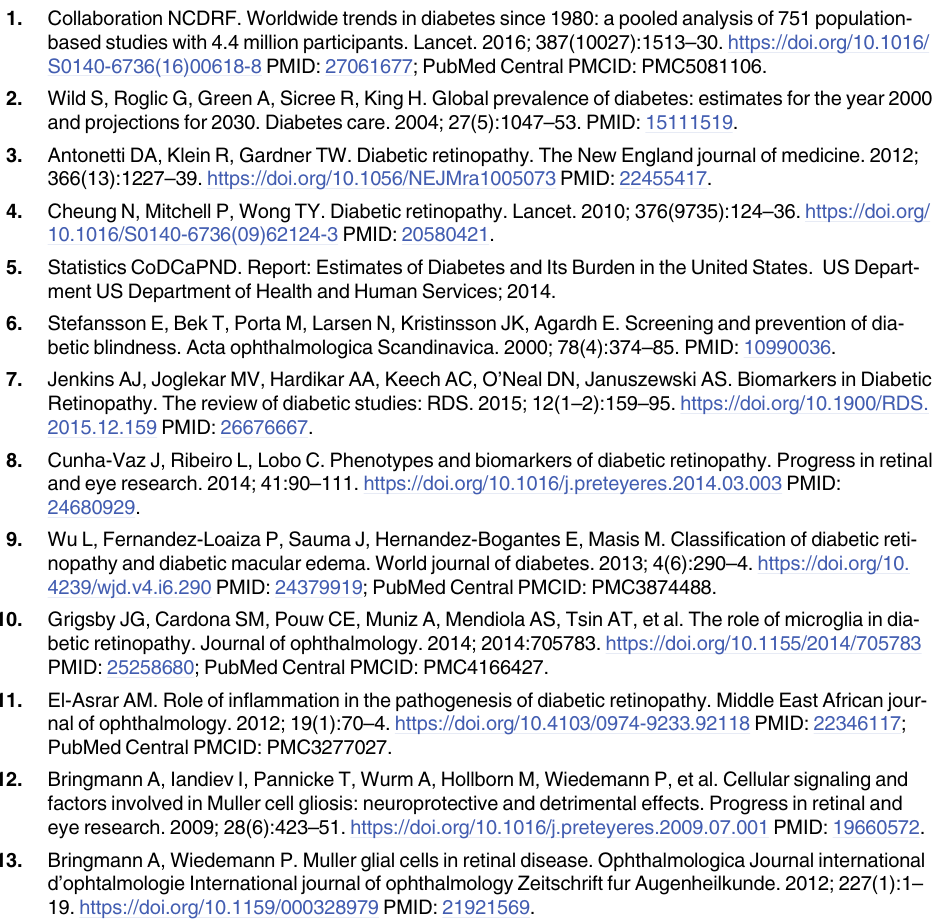
S1 Table. Demographic information (age, gender, patient group, type of DM, DR sub- group, HbA1c level) and cytokine levels (pg/ml) in vitreous samples of control (white) and DR patients (grey; DME patient is labeled in